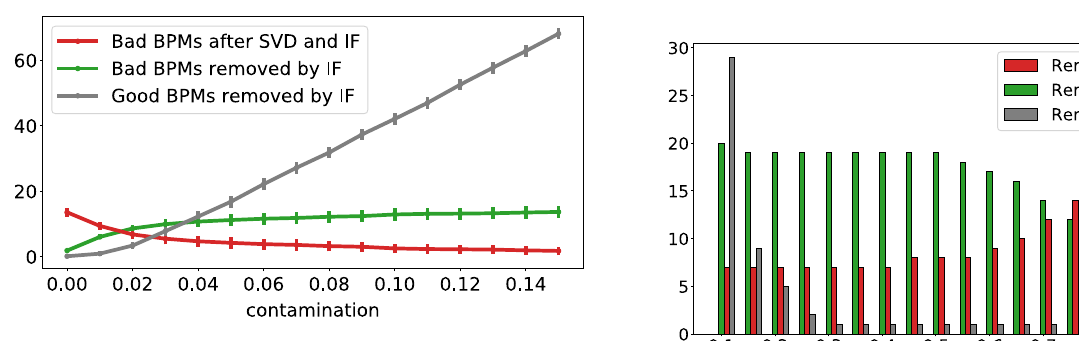
FIG. 6. Adjustment of contamination factor of the IF algorithm. The target is to keep the number of bad BPMs remaining after applying SVD and IF low, while avoiding a significant number of good BPMs to be wrongly identified as bad.